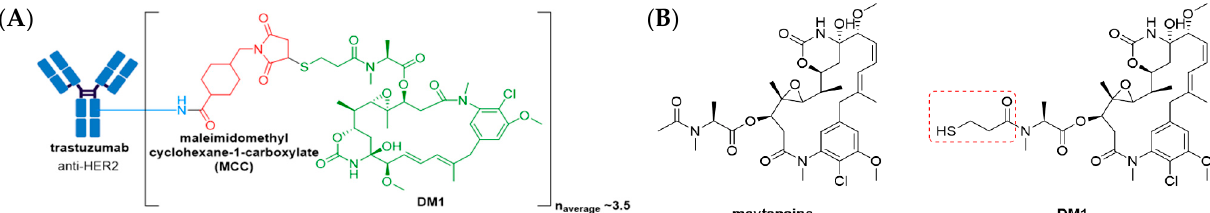
Figure 8. ( A ) Structure of Kadcyla ® (ado-trastuzumab emtansine). The antibody is shown in blue, and chemical structures for linker and payload are in red and green, respectively. ( B ) The chemical structure for maytansine and DM1. The thio- propanoyl group of DM1, which allows for conjugation to a maleimidomethyl cyclohexane-1-carboxylate (MCC) group is shown in the red box.